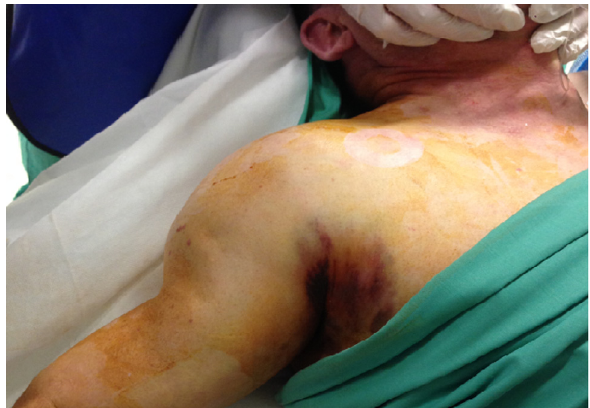
Figure 2. Deformation of the shoulder and hematoma in the deltopectoral